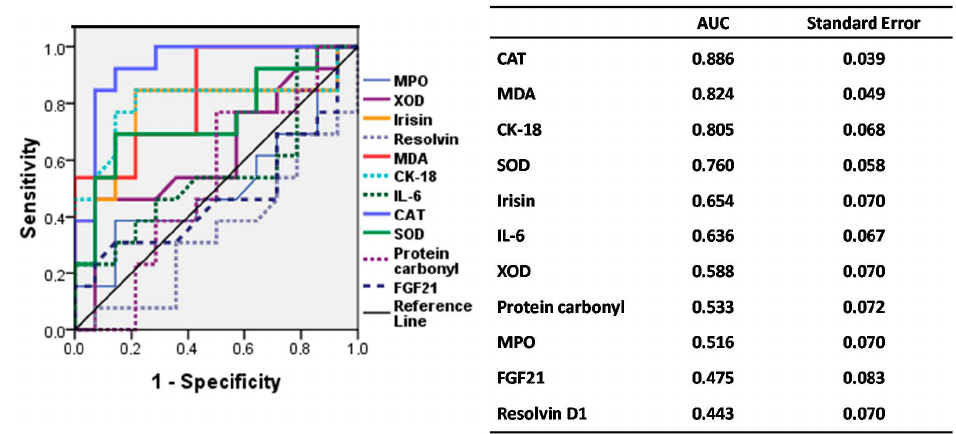
Figure 2. ROC curve of the accuracy of biomarkers in the assessment of the intrahepatic fat content. AUC: Area under the curve; CAT, Catalase; MDA, Malondialdehyde; CK-18: Cytokeratin 18; SOD, Superoxide dismutase; IL-6, Interleukin 6; XOD, Xanthine oxidase; MPO, Myeloperoxidase; FGF21: Fibroblast Growth Factor 21.